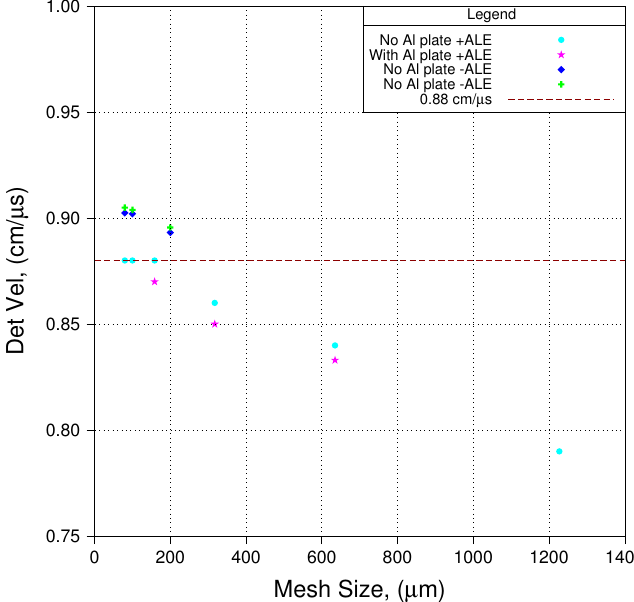
Figure 13. Detonation